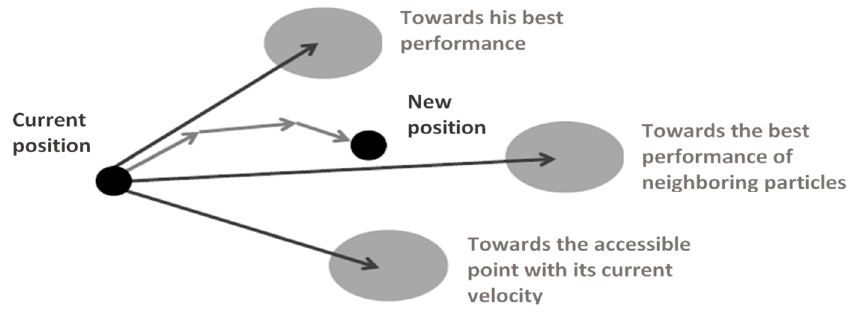
Figure 3. Displacement of a particle